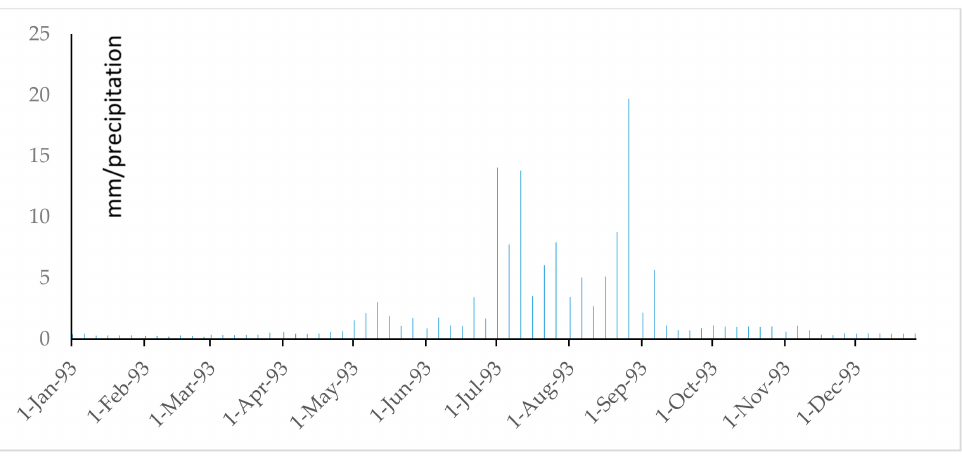
Figure A21. Precipitation of Denko County in